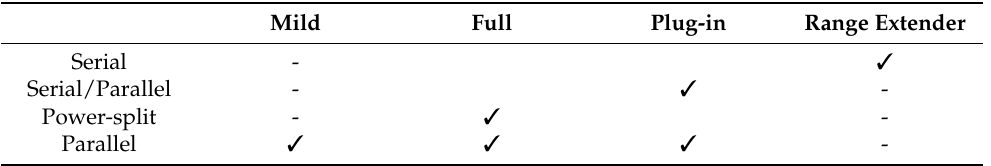
Table 1. Powertrain architecture and electrification degree of the tested vehicles (unlikely or unrealis- tic configurations marked with a dash).